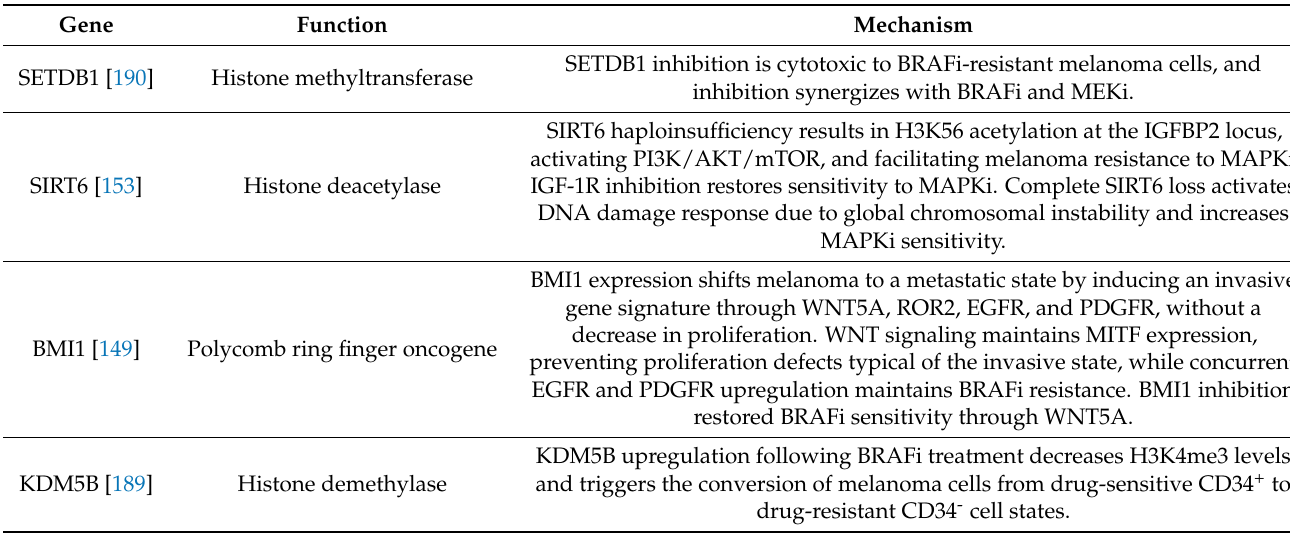
Table 2. Epigenetic regulators of targeted therapy